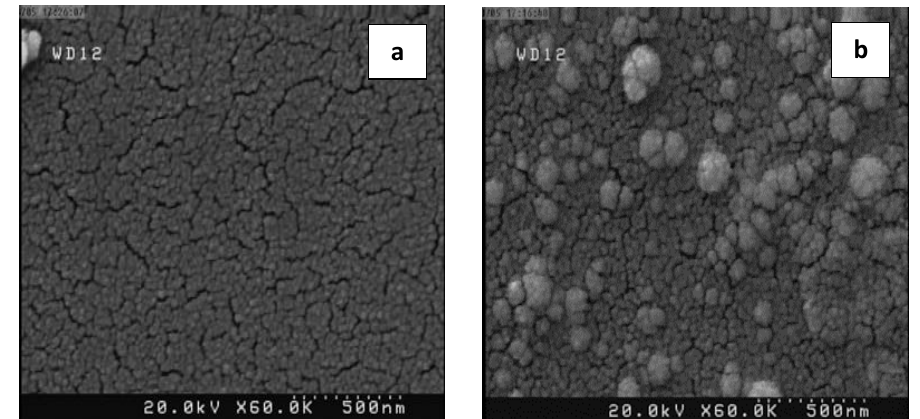
Figure 4: FESEM images of Co